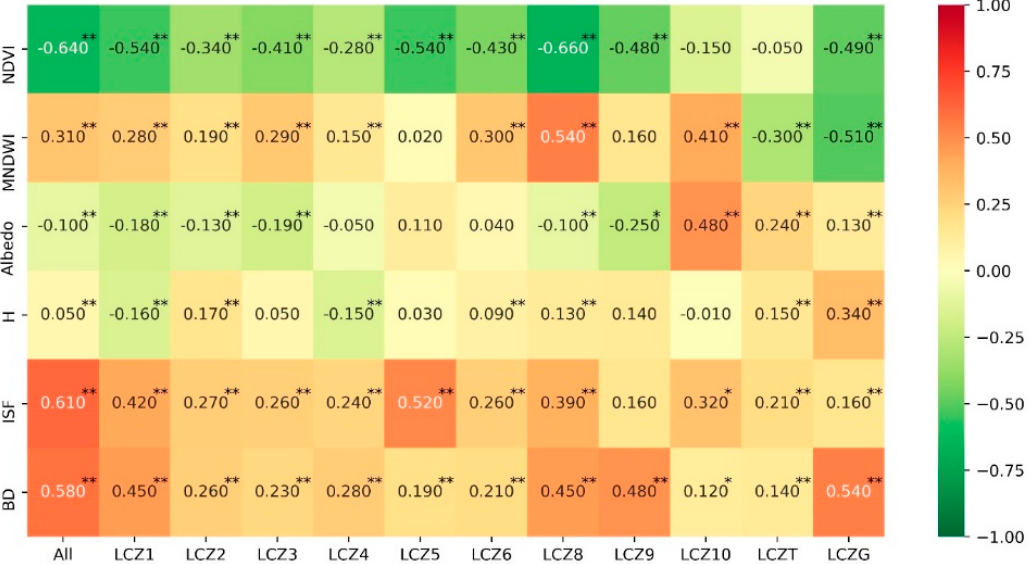
Figure 10. Pearson correlation coefficients between the urban morphology indices and SUHI N . (** The significance level is 0.01, * the significance level is